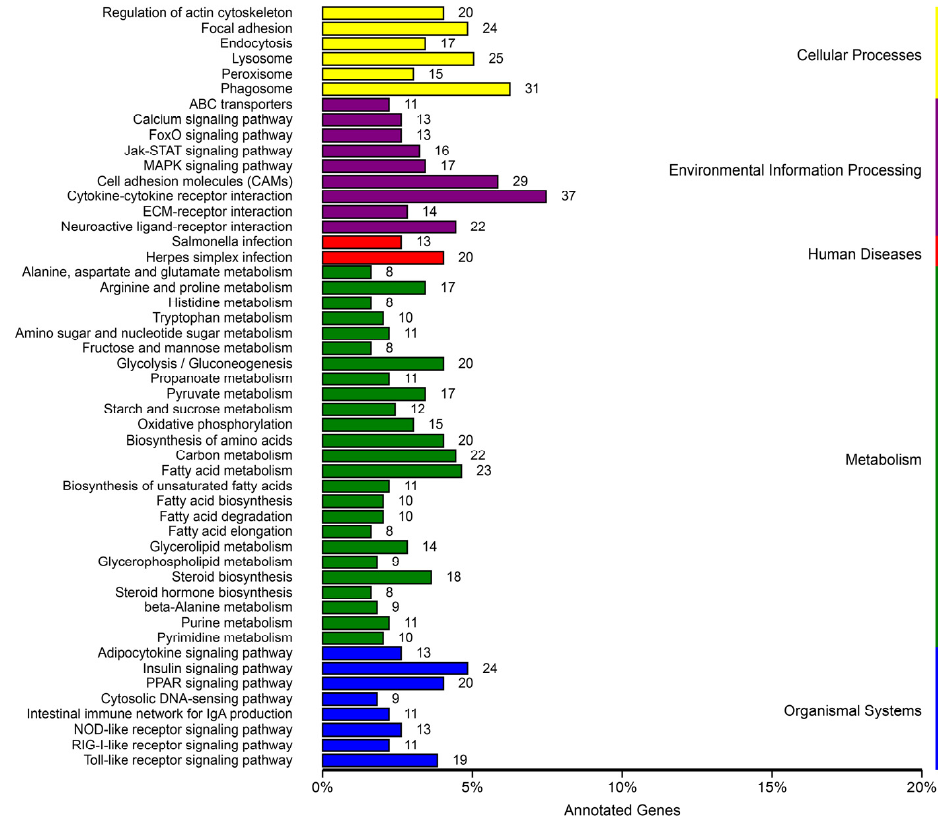
Figure 5. Kyoto encyclopedia of genes and genomes (KEGG) pathway categorization of DEGs with a corrected p -value of 0.05 in the treatment and control group comparisons.